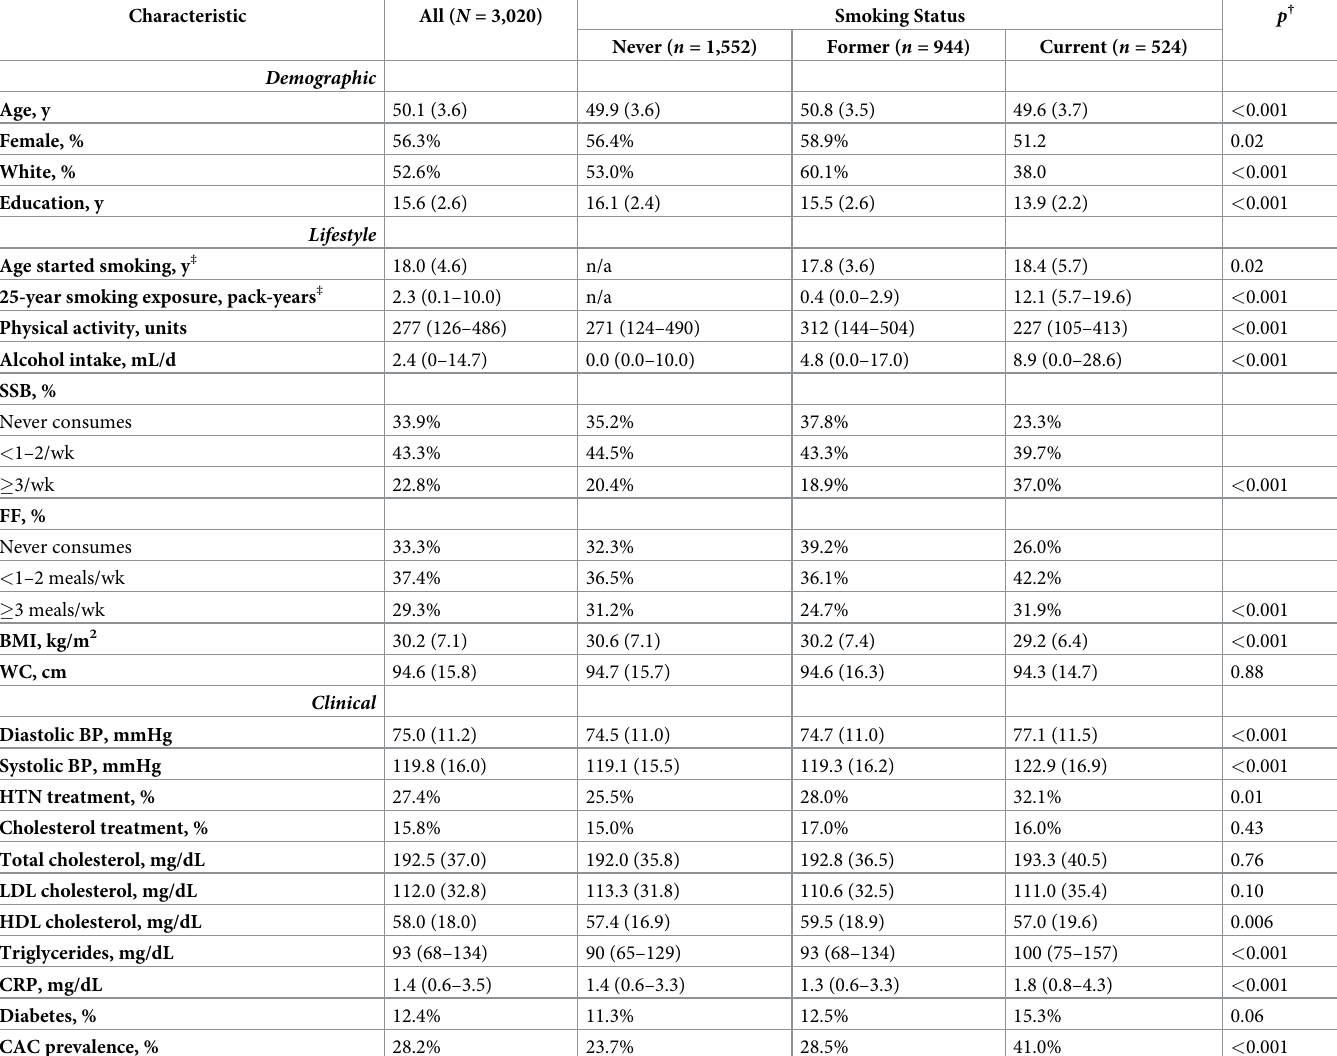
Table 1. Participant characteristics at Y25 visit according to Y25 smoking status �